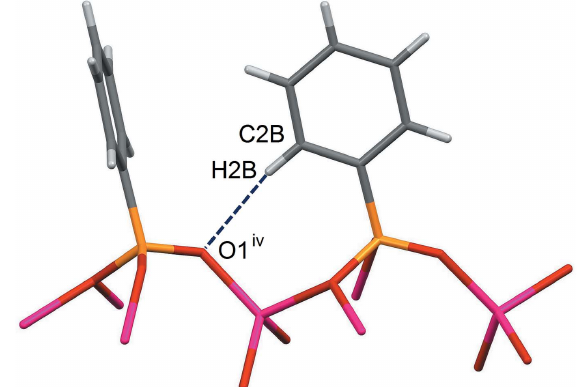
Figure 3 View along the b -axis direction of the intramolecular hydrogen bond (blue dotted line) in I . Symmetry code: (iv) x , (cid:4) y + 3